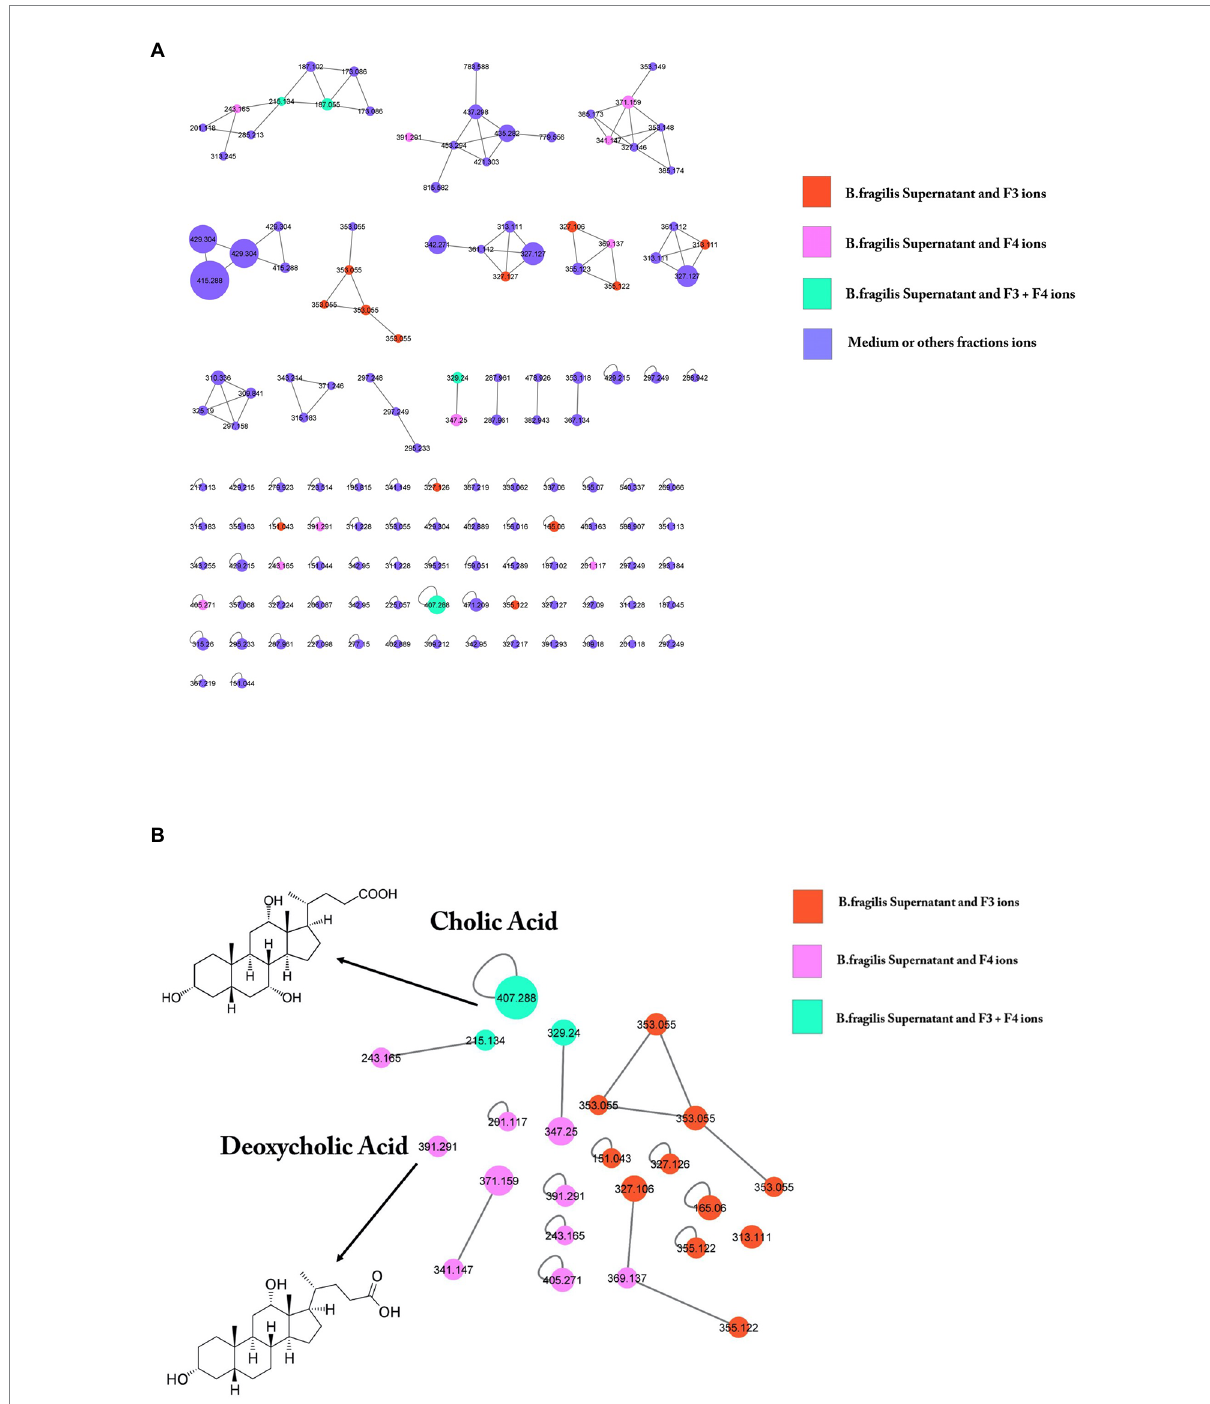
FIGURE 7 GNPS molecular networking of negative ion MS/MS spectral data showing a selection of ions in bioactive fractions (F3 and F4). (A) Data were recorded in negative ionization mode. The nodes display the measured average masses of the molecular ions with identical MS/MS spectra. The numbers on the nodes represent the parent mass of the molecules. Node size reflects the bioactivity scores of the ions; node color indicates the abundance in the different conditions. The nodes in orange correspond to compounds present both in B. fragilis supernatant and in F3; nodes in pink correspond to compounds present both in supernatant and F4; nodes in green correspond to compounds present in all (supernatant, F3 and F4); nodes in purple correspond to ions solely found in DMEM. GNPS analysis of B. fragilis supernatant and bioactive fractions after LC–MS/MS showed the presence of 24 specific molecules of these fractions, 11 molecules for F3, 10 molecules for F4, and 3 molecules for both. (B) Among them, cholic acid (CA) and deoxycholic acid were